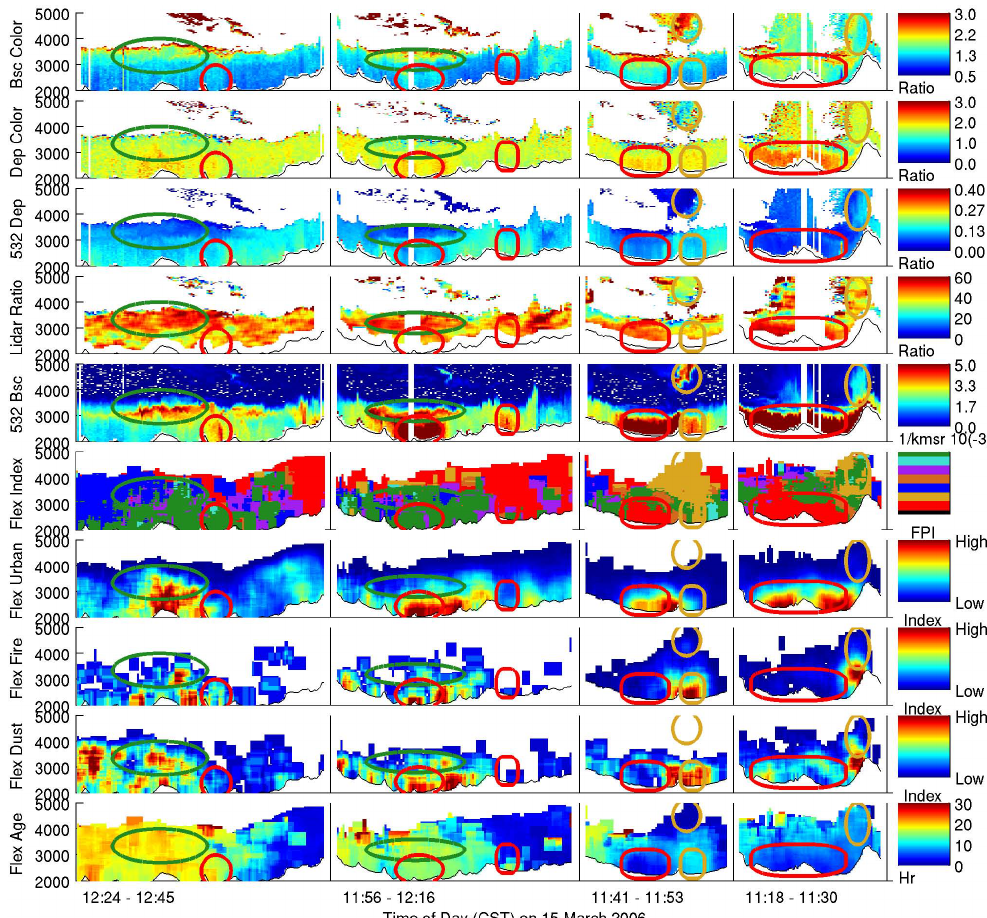
Fig. 9. Curtain plots of HSRL backscatter coefficients and intensive properties for four transects on 15 March along with Flexpart average age and particle count index for dust, fire and urban emissions. See Fig. 12 for Flexpart Particle Index (FPI) legend. The yellow ellipses show biomass burning plumes, the red ellipses show the urban plume and the green ellipses show mixed plumes. The y-axis is height above mean sea level. All transects are shown from west to east. From left to right the transects correspond to the trajectories from north to south in Fig. 7b. (Please note that the aircraft flew from south to north on this occasion, so that the first transect in time is shown on the